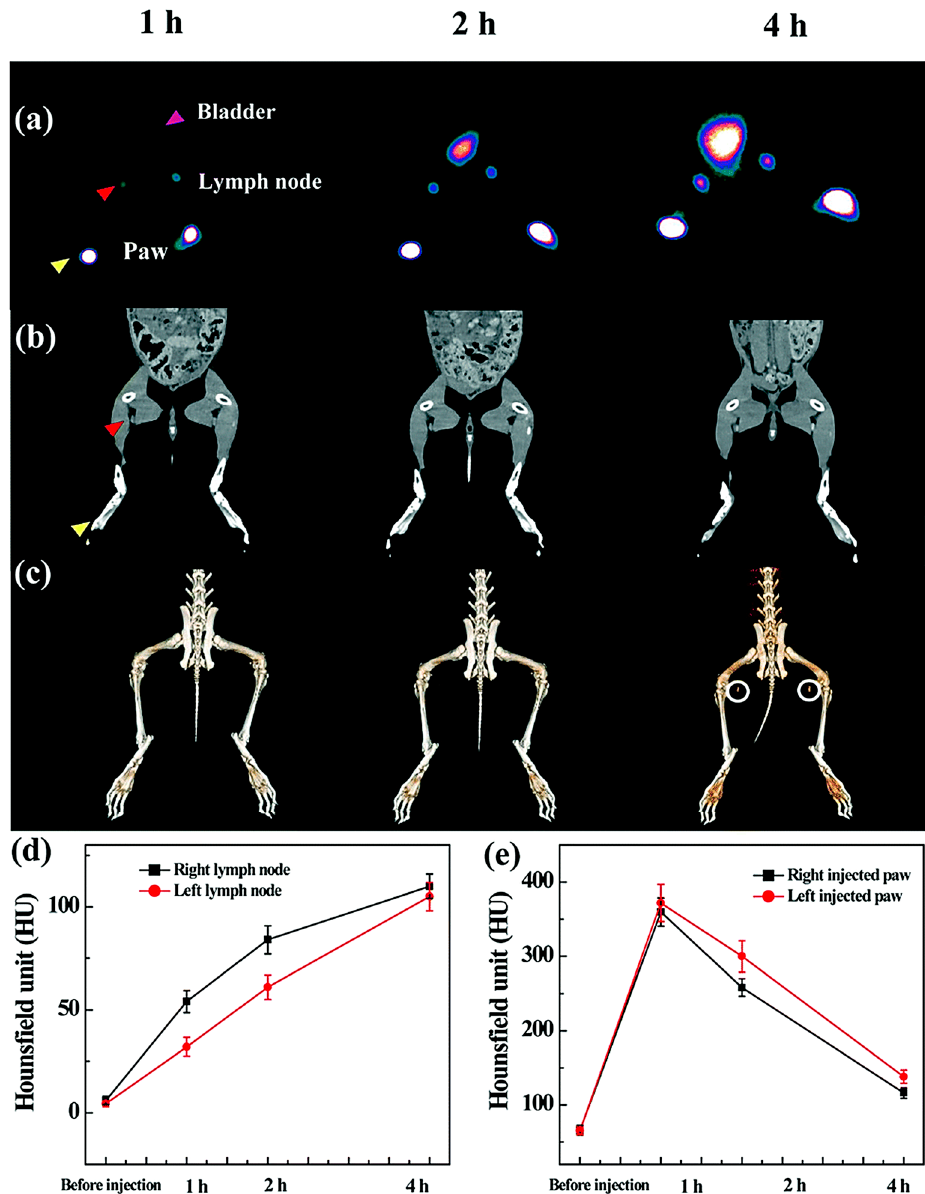
Figure 3. SPECT ( a ) and CT ( b ) imaging of a rabbit after hock injection of the 99m Tc-Au-Ac DENPs (left) and the 99m Tc-Au-Gly DENPs (right) at different time points and the corresponding 3D renderings of in vivo CT images ( c ); ( d , e ) Show the CT value of the lymph node and the injection paw before and at different time points post intravenous injection of the corresponding particles (adapted from [75], Journal of Materials Chemistry B, 2017).